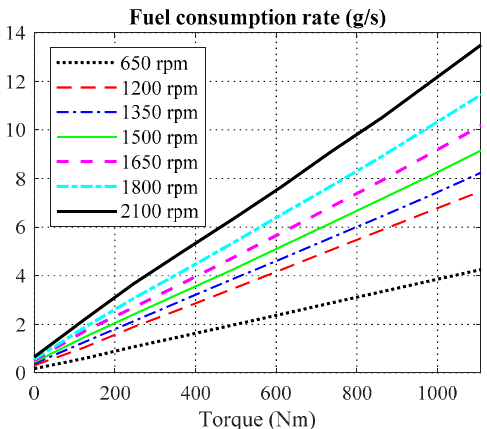
. m fuel ) map used in this study (Detroit Diesel